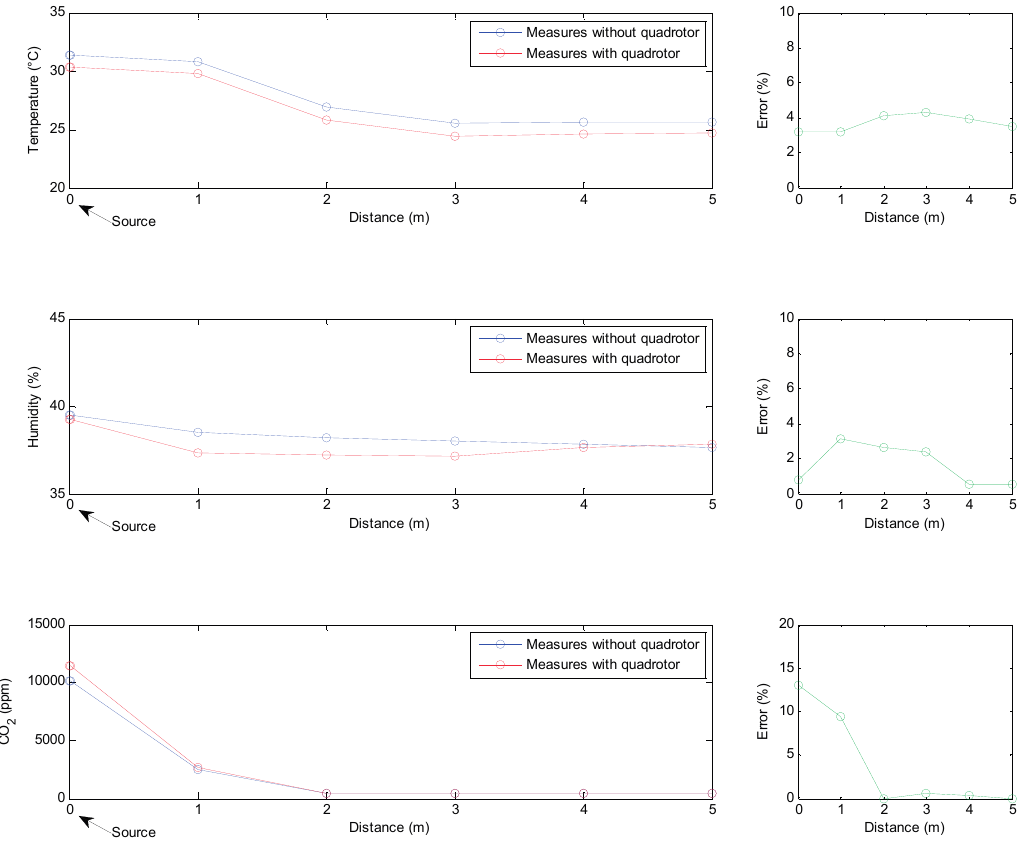
Figure 9. Temperature, humidity and CO 2 measured with propellers stopped and